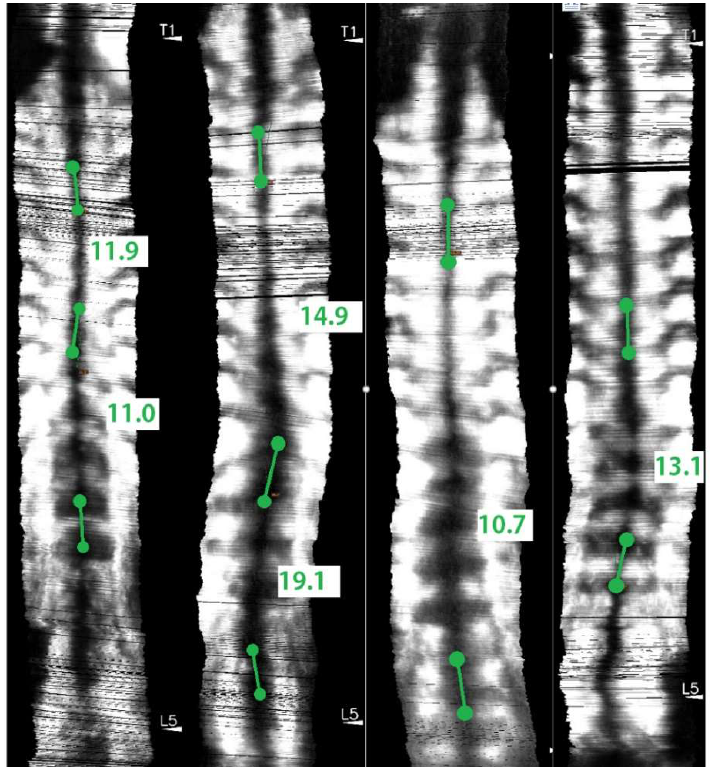
Figure 6. Coronal ultrasound images of subjects with various scoliosis severities using Scolioscan Air with SPA measurement.